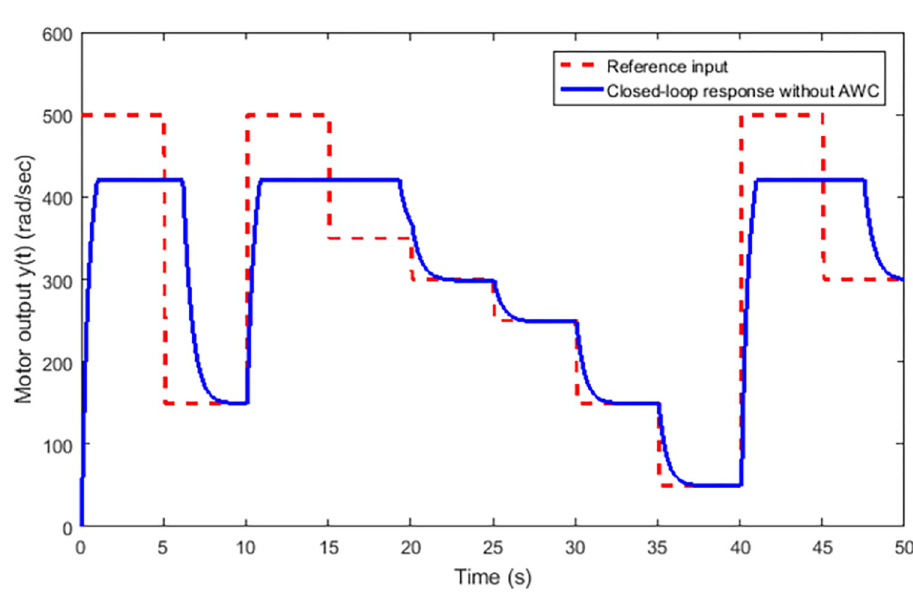
Fig 9. Response without AWC under sensor